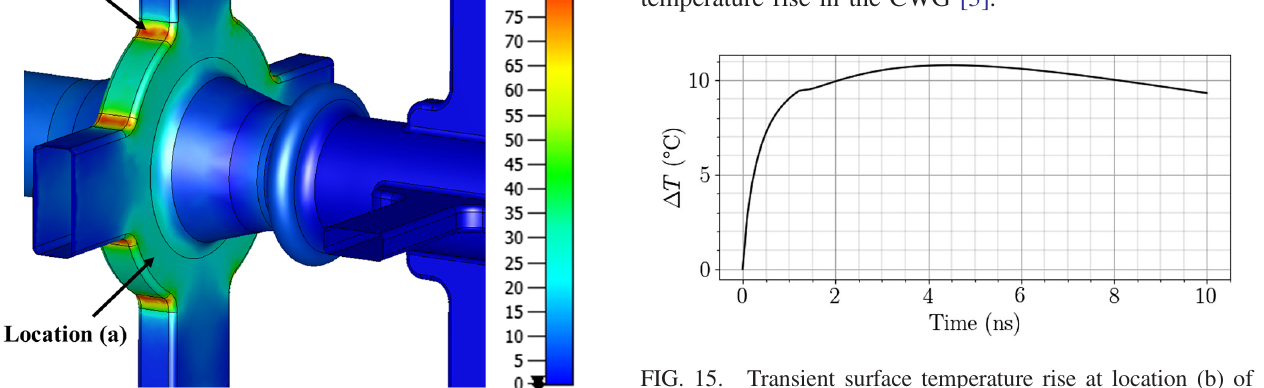
FIG. 15. Transient surface temperature rise at location (b) of Fig. 14, showing a maximum of Δ T ¼ 10 . 9 °C occurring 4.5 ns from the beginning of the pulse. Computed for a structure with ¼ 398 W m − 1 K − 1 electrical conductivity of 4 × 10 7 S m − 1 , k T